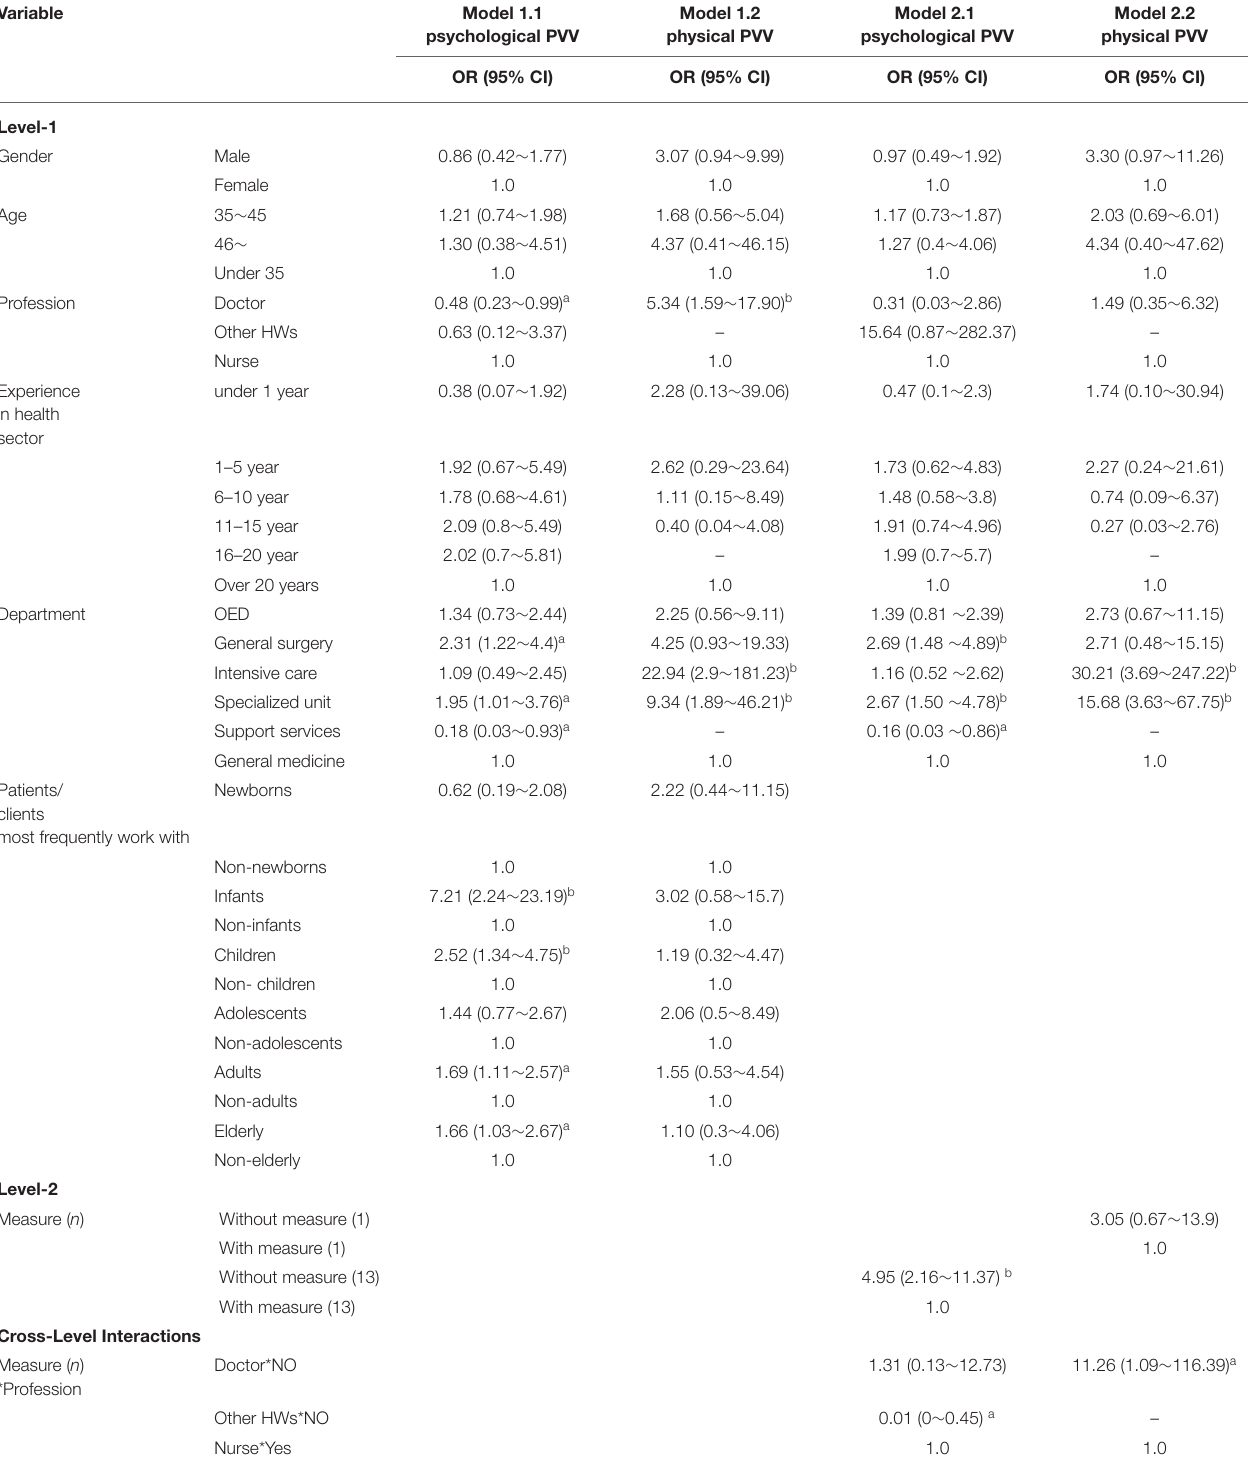
TABLE 3 | Results of multilevel logistic regression models: worker characteristics, measures and cross-level interactions ( n = 754).